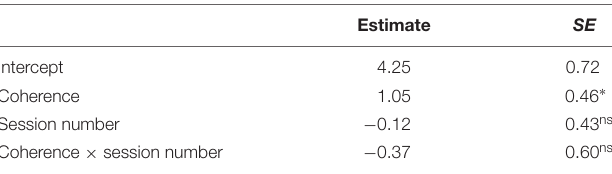
TABLE 5 | Model testing for the effect of semantic coherence on